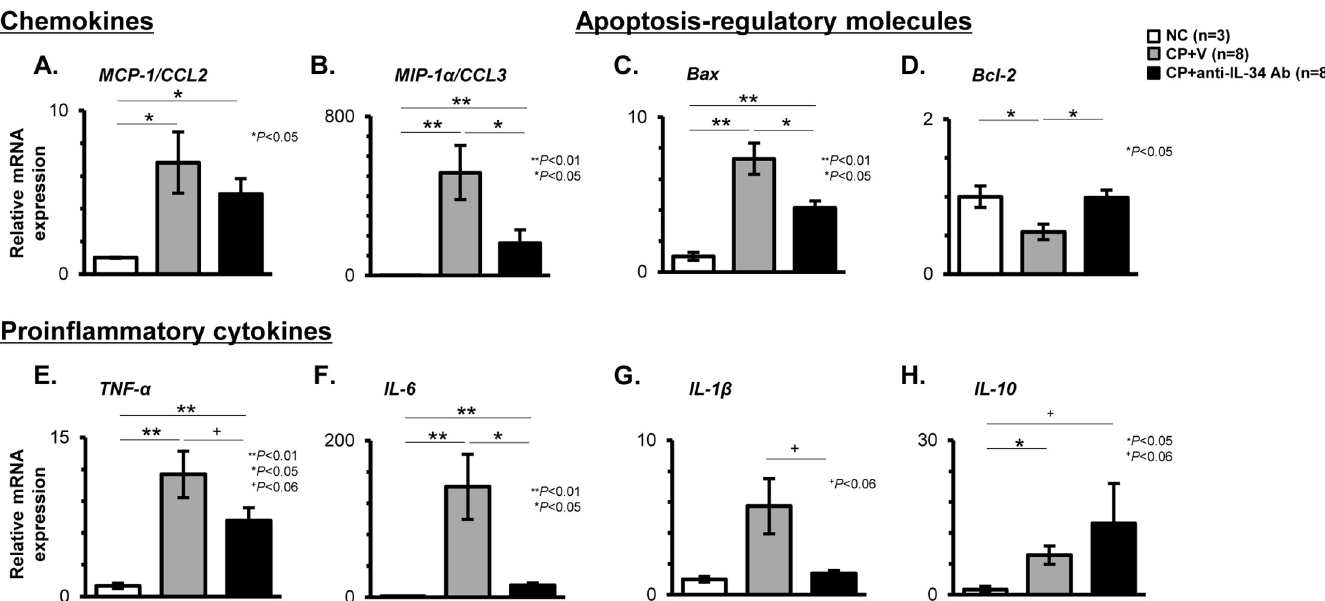
Fig 6. Intra-renal expression of chemokines, apoptosis-regulatory molecules, and proinflammatory cytokines in CP-N mice. Real-time RT-PCR for genes encoding MCP-1/CCL2 ( A ), MIP-1 α /CCL3 ( B ), Bax ( C ), Bcl-2 ( D ), TNF- α ( E ), IL-6 ( F ), IL-1 β ( G ), and IL-10 ( H ) among the NC, CP+V, and CP+anti-IL-34 Ab groups of mice. Values were normalized to the GAPDH transcript, and are expressed as the relative ratio. Data are expressed as the mean ± SEM. The Mann-Whitney U test was used for statistical analysis.